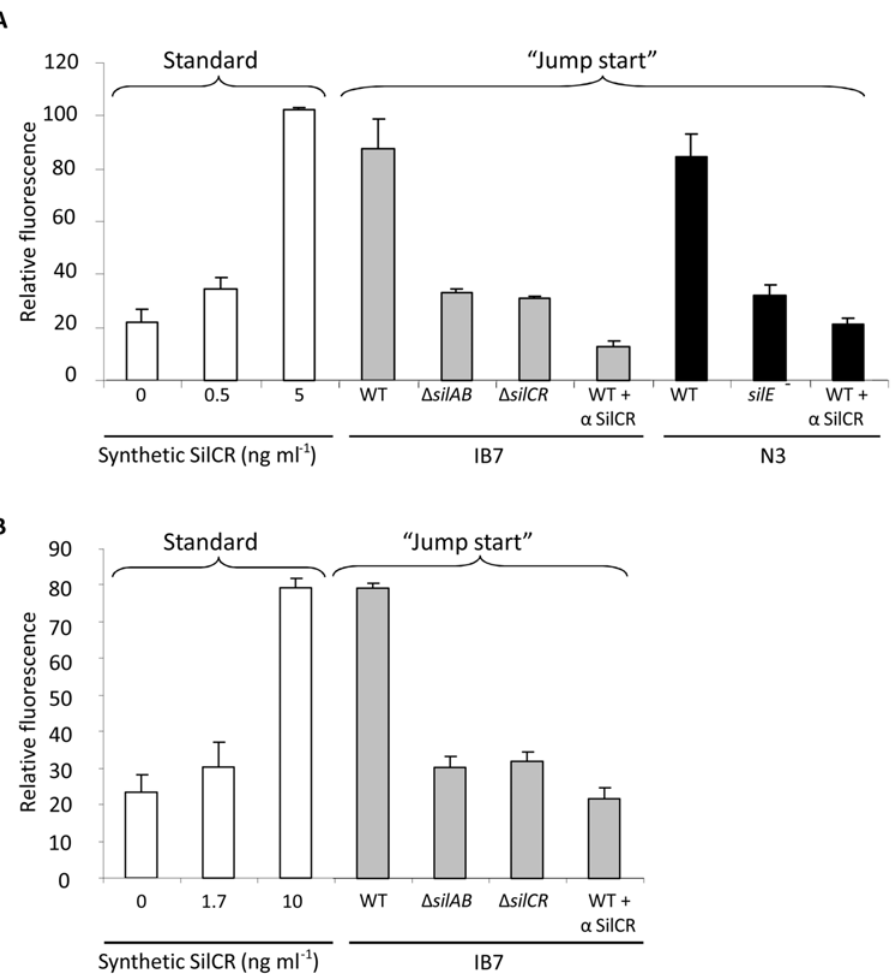
Figure 7. SilCR production and sensing by GAS and GGS. (A) GAS can sense SilCR produced by GAS IB7 and GGS N3. Relative fluorescence was determined for the JS95p P 4 -gfp ‘‘reporter strain’’ when grown with synthetic SilCR at the indicated concentrations (‘‘Standard’’, white bars) or in the presence of 10-fold diluted supernatants (‘‘Jump start’’) from IB7 (grey bars), N3 (black bars) and their derived mutants. a SilCR denotes addition of serum containing anti-SilCR polyclonal antibody [12], diluted 1:40 into the reporter strain tube immediately before addition of the 10-fold diluted supernatants of the tested strains. The values shown are the mean 6 the standard deviation results of at least two independent experiments. (B) GGS can sense SilCR produced by GAS IB7. Relative fluorescence of the N9p P 4 -gfp ‘‘reporter strain’’ when grown with synthetic SilCR at the indicated concentrations (‘‘Standard’’, white bars) or in the presence of 3-fold diluted supernatants (‘‘Jump start’’) from IB7 WT and D silAB , D silCR mutants (grey